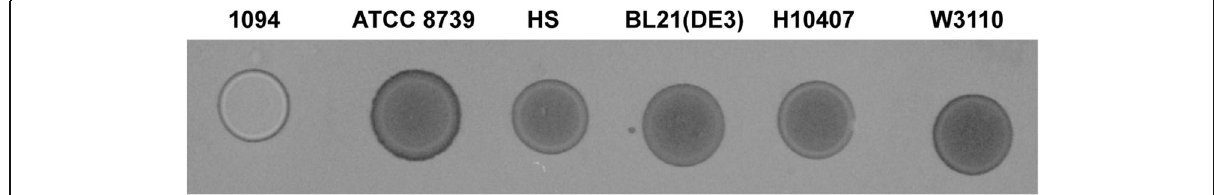
Fig. 6 Cellulose production in six E. coli strains. Cellulose secretion was evaluated by the binding of calcofluor (CF), as visualized by colony fluorescence under ultraviolet light (fluorescence appears white in image). Five microliters of an overnight culture was spotted onto LB agar plates, containing 0.02% of CF and incubated for 24 h at 30 °C. Images were acquired using a G:BOX imaging system (Syngene, Frederick,